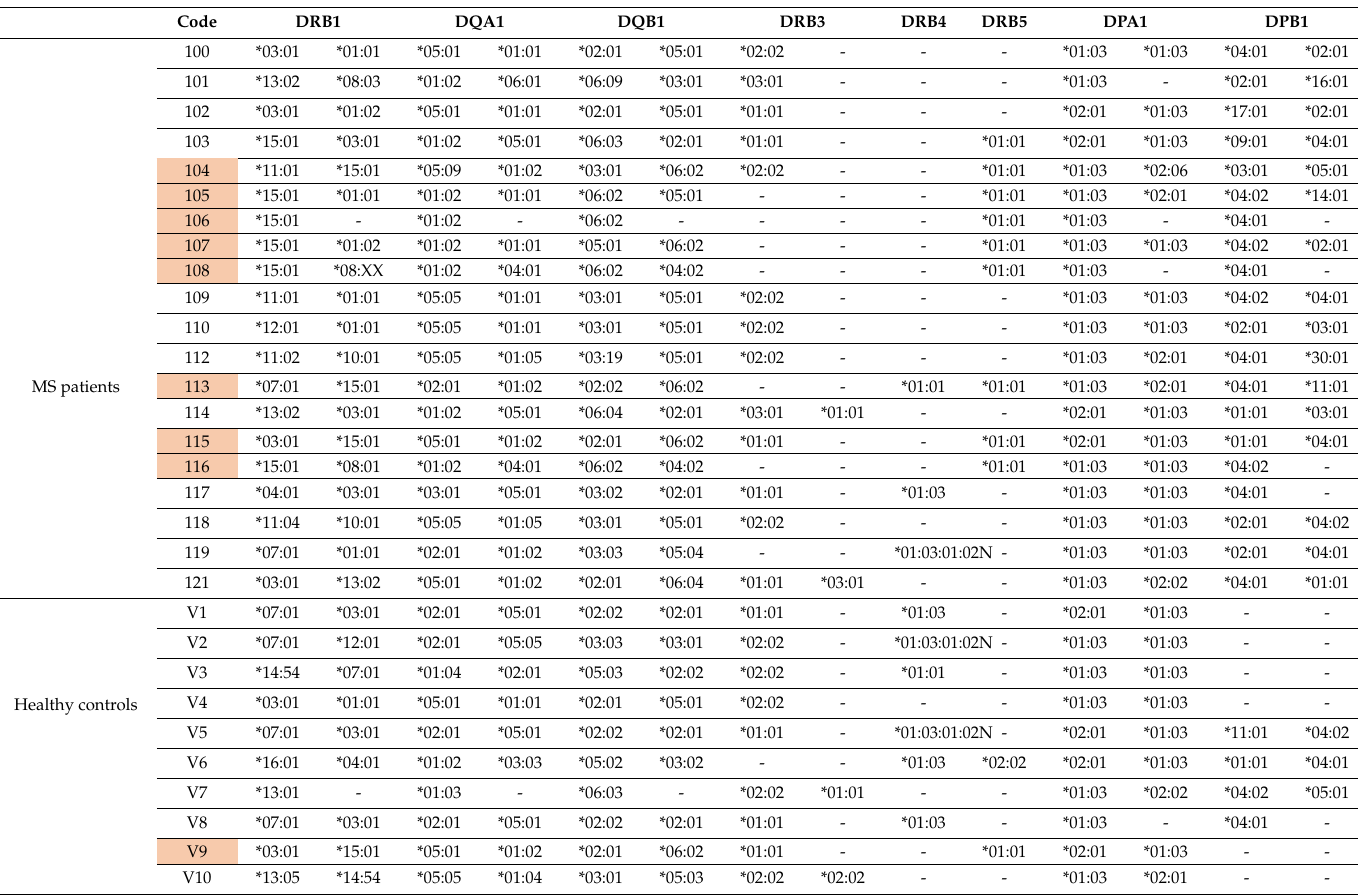
Table 3. Human leukocyte antigen (HLA) class II genotyping of study